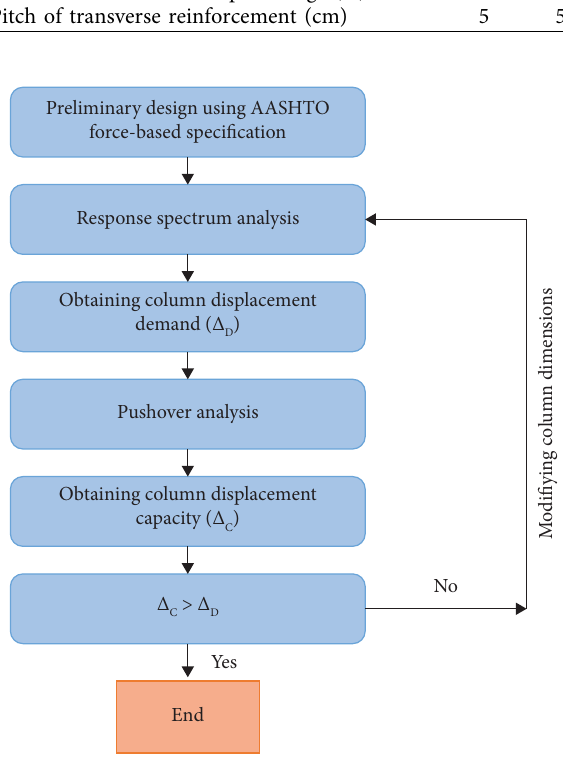
Figure 1: Design